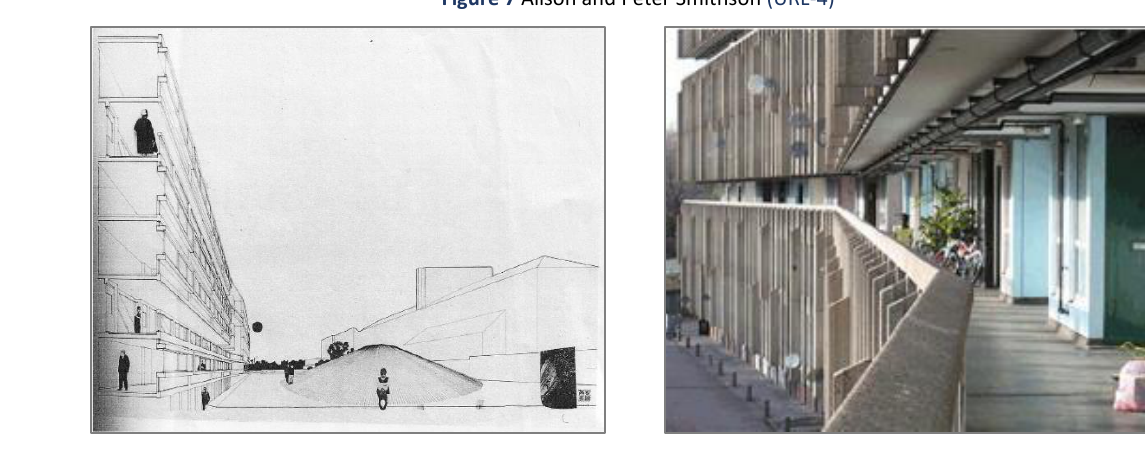
Figure 8 Alison and Peter Smithson, initial drawing of Robin Hood Gardens (URL-5)